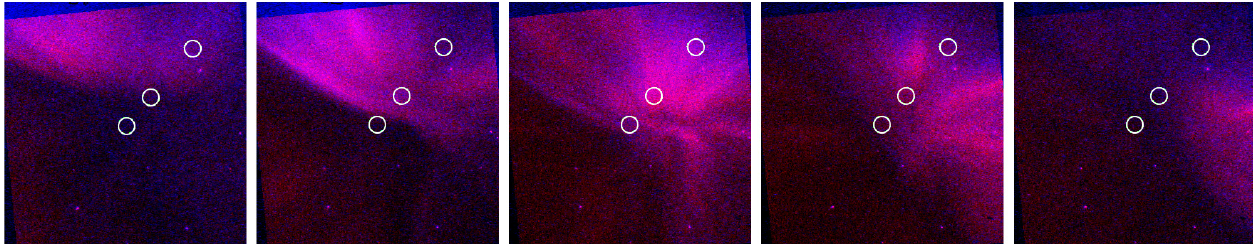
Fig. 6. Multi-wavelength composite image showing the optical (OII) enhancement associated with the NEIAL signature at 09:39:03UT. The frames shown were taken at 09:38:53, 09:38:58, 09:39:03, 09:39:08 and 09:39:13UT from left to right. The direction of north is vertically downwards and the east direction is to the left for the image orientation as shown here. The white circles shown progressively further out from the centre of the image, represent the position of the ESR beam (FWHM 0.6 degrees) at altitudes of infinity, 300km and 110km respectively. The result of not taking into account the parallax effect, i.e. effectively assuming infinite altitude, can clearly be